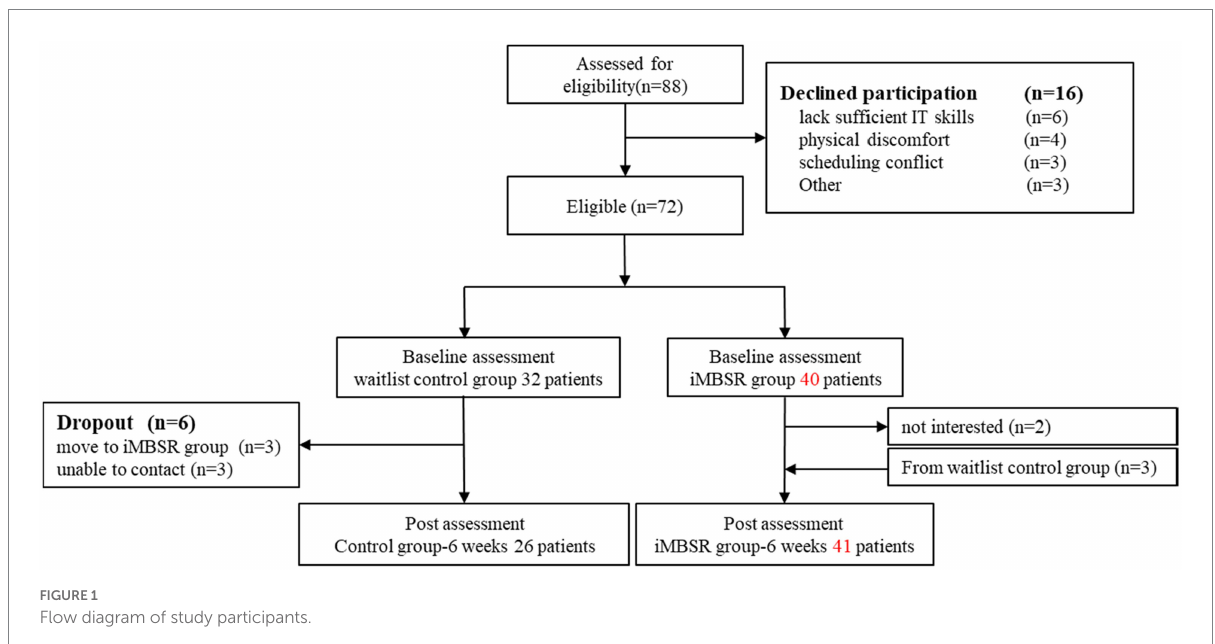
FIGURE 1 Flow diagram of study participants.